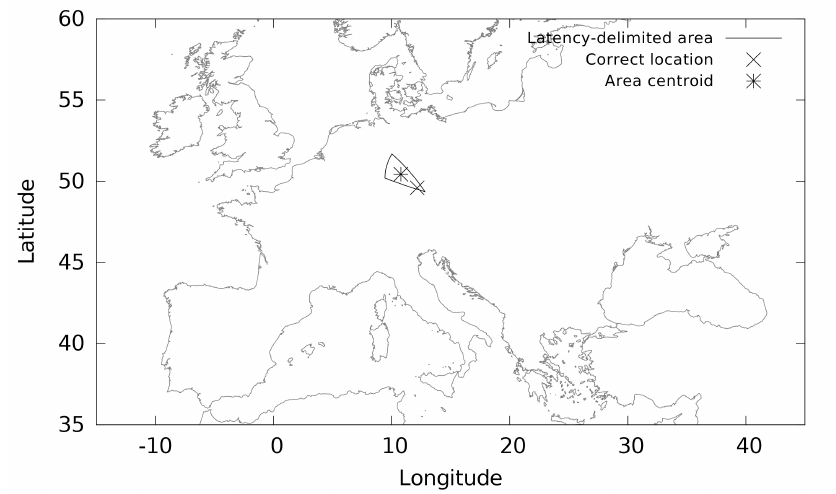
Figure 6. Delimited area as a product of multiple great-circle